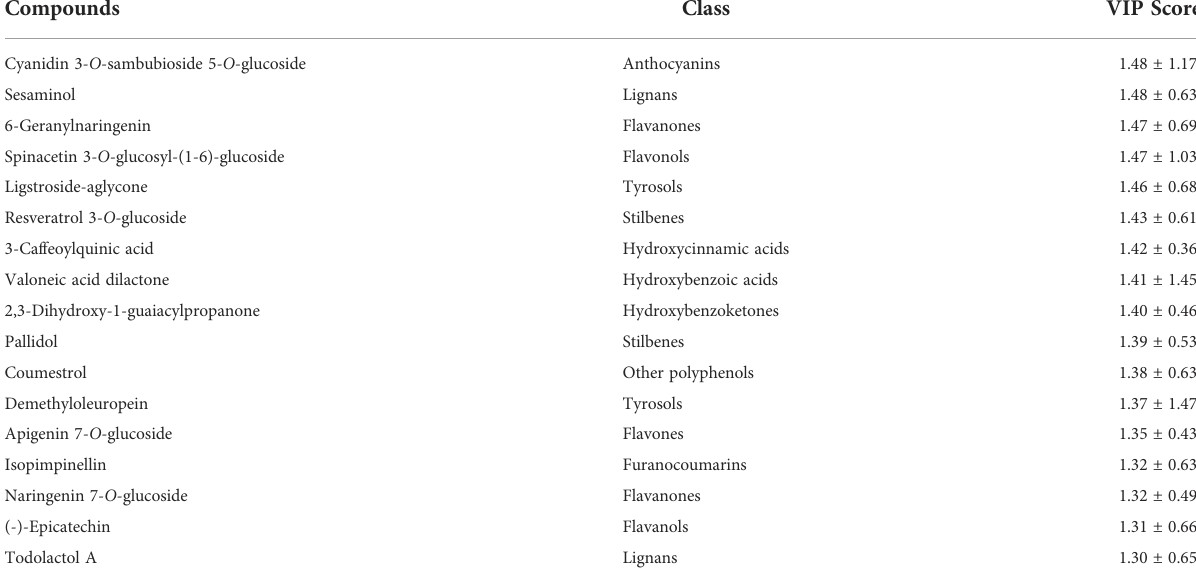
TABLE 2 Discriminant metabolites identi fi ed as VIP markers selected from the OPLS-DA model were performed for the elicitation of BH PCSCs.